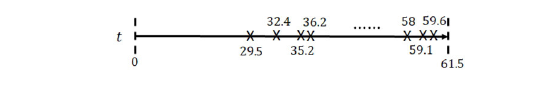
FIGURE 2 | Visualization of the structure of process data from CC item in PISA